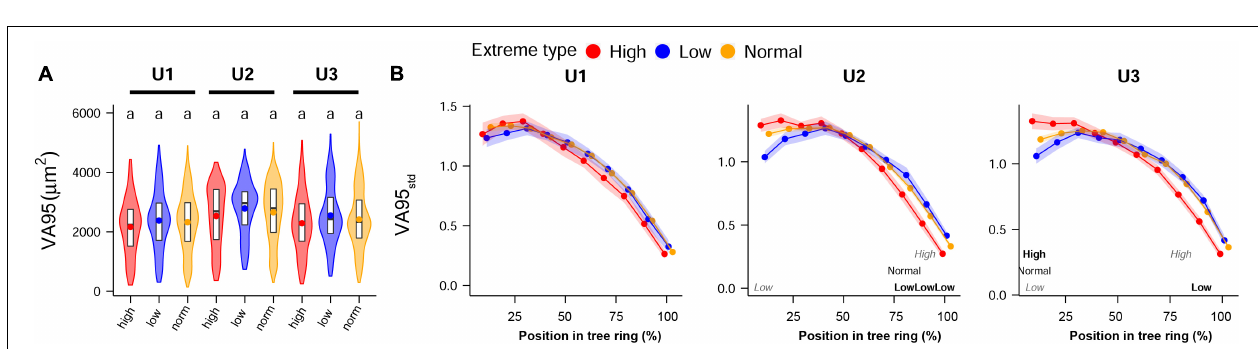
FIGURE 7 | (A) Inter-annual and (B) standardized intra-annual values (standardized to the annual mean) of VA95 studied at the 5 years with the highest and lowest temperatures during the dry trimester June–July–August in the time period 1968–2004 at the different study sites: U1—1,200 m a.s.l.; U2—1,600 m a.s.l.; U3—1,950 m a.s.l. Panel (A) shows violin plots, with boxplots (1st, 2nd, and 3rd quartiles), and mean values (dots); letters indicate significant differences between sites. Panel (B) shows mean values (dots) and 95% CI (shaded area); letters indicate if values are significantly higher ( bold ), lower ( italics gray ), or if they are significantly different at all sites (regular format indicates the middle value). If both the bold and italics gray are shown, this means that the mid-value was the only one that did not differ significantly. Permutation test of independence, P < 0.05. For the anatomical trait abbreviations, Figure 2